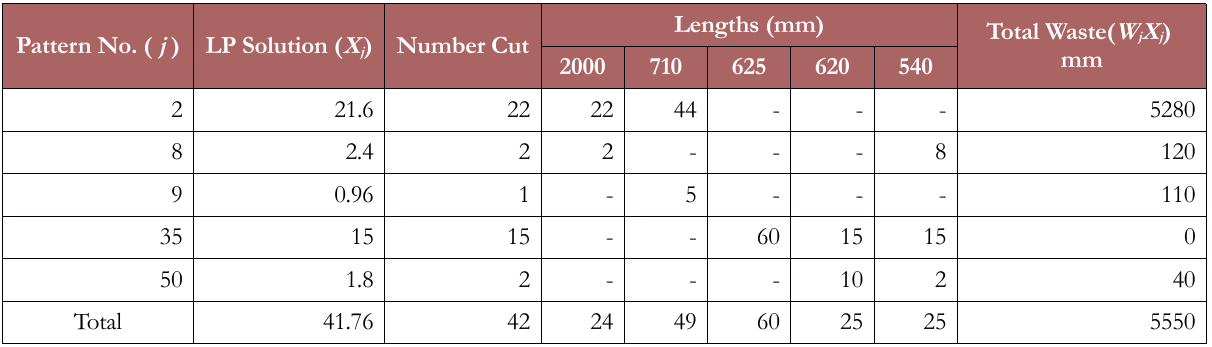
Table 6. Solution to Case I problem (Flush Door)